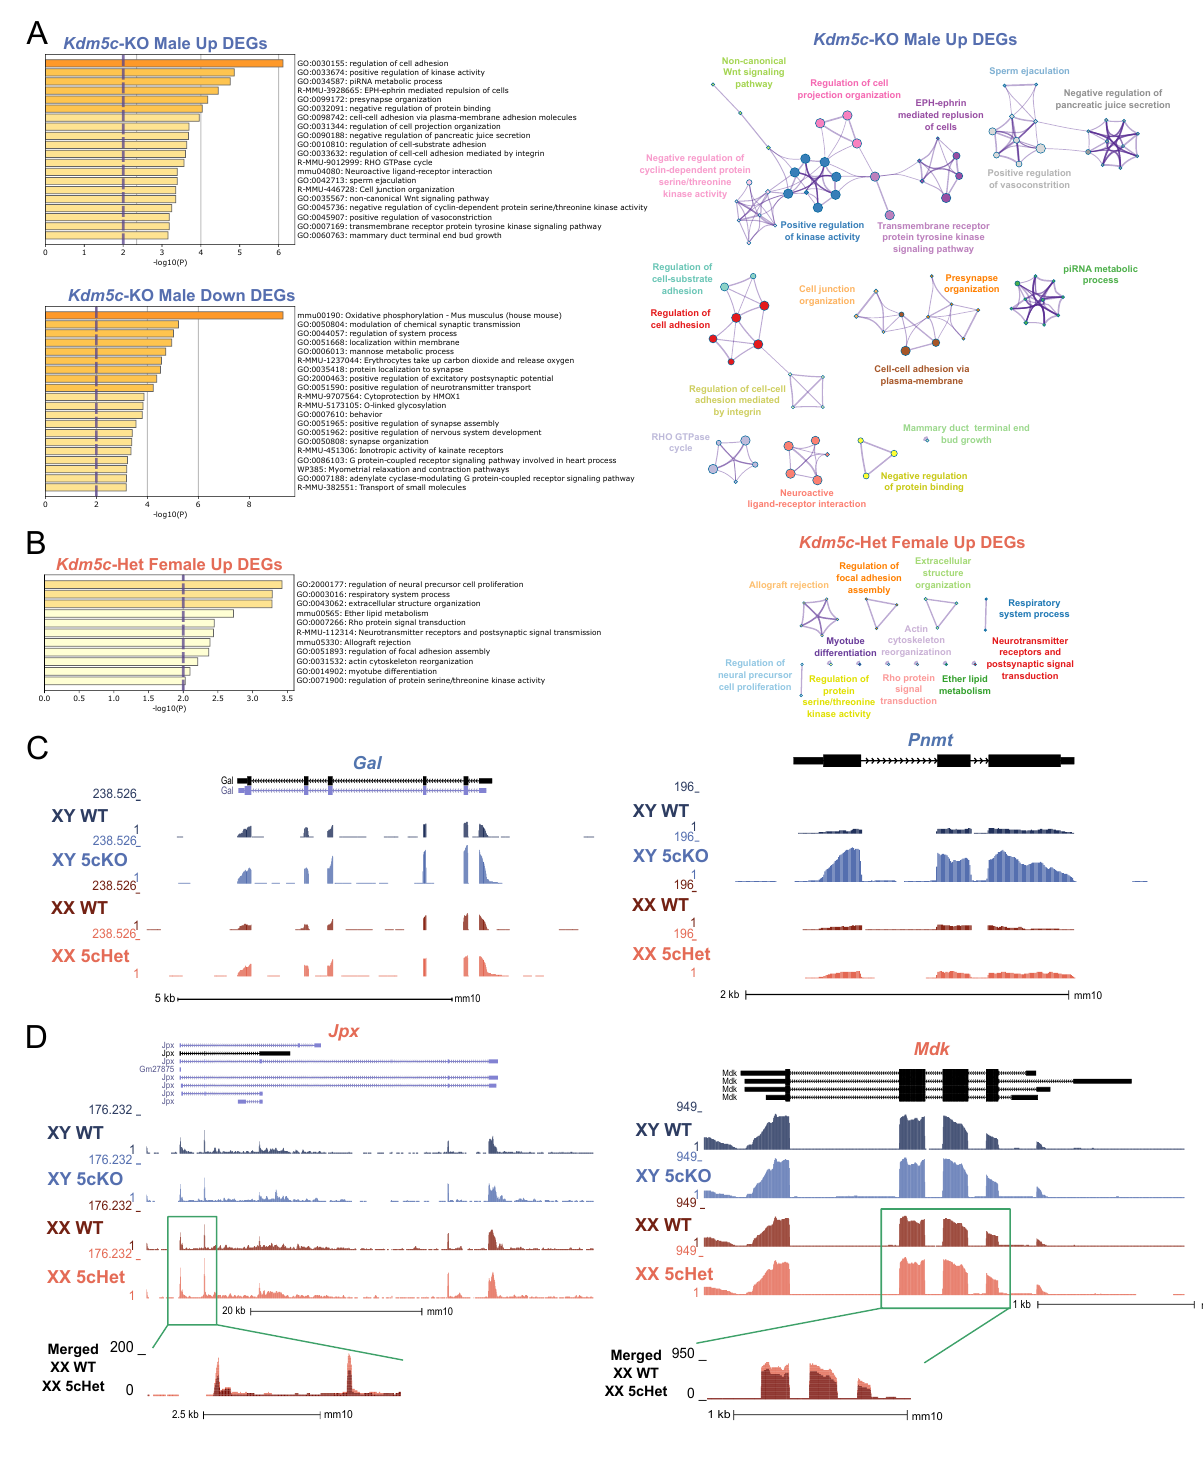
Figure 2. Sexually dimorphic changes in genes related to development, aggression, and memory with loss of Kdm5c . ( A , B ). Top gene ontology (GO) terms from Metascape for DEGs in Kdm5c -KO males ( A ) and Kdm5c -HET females ( B ). The purple dashed lines indicate the significance threshold. Right— Metascape GO enrichment map. Colors: enrichment networks, nodes: gene ontologies, edges: ontologies with a Kappa similarity greater than 0.3, thicker edges representing a greater Kappa similarity. ( C ). UCSC genome browser view of two genes, Gal and Pnmt , uniquely upregulated in Kdm5c -KO males (XY 5cKO) but not in Kdm5c -HET females (XX 5cHet). ( D ) Two genes, Jpx and Mdk , are uniquely upregulated in XX 5cHET but not in XY